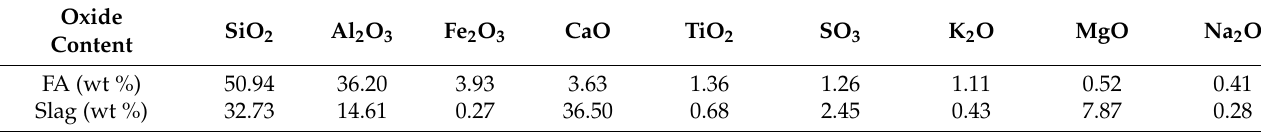
Table 1. Chemical composition of the binders.